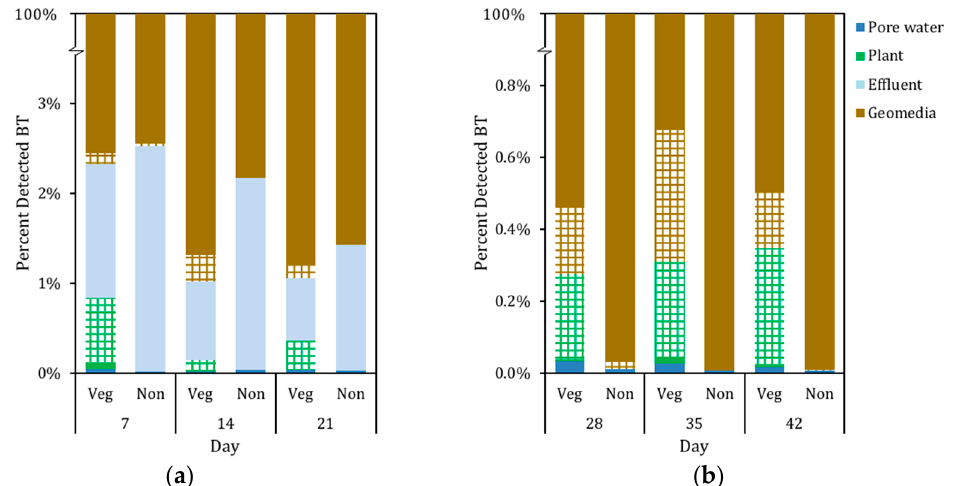
Figure 7. Plot showing the mass distribution of BT (solid fill) and BT metabolite GBT (hatched fill) detected in vegetated and nonvegetated biofilter mesocosms after the storm events ( a ) and during the extended monitoring period ( b ). Metabolite GBT mass is reported in percent BT mass equivalents. Note the break in the y -axis.